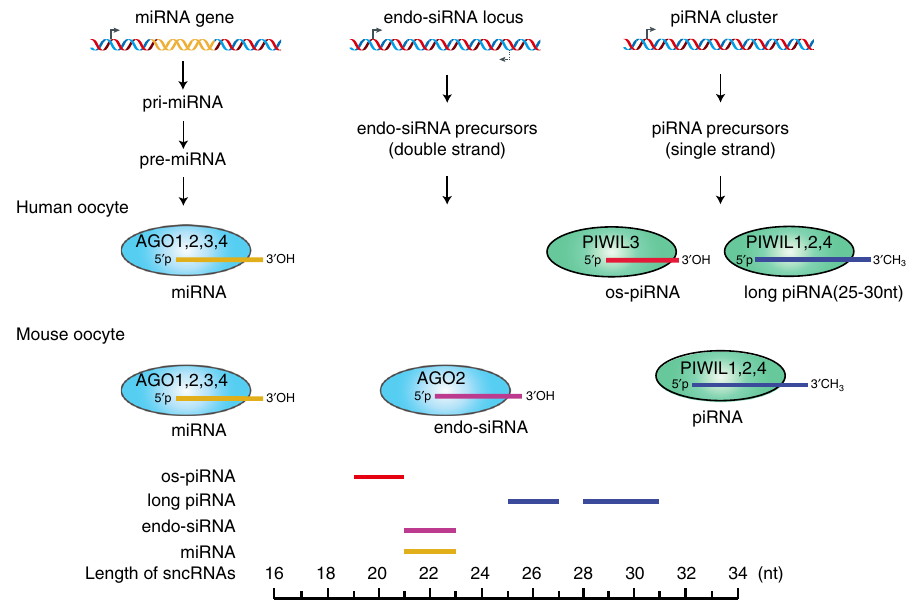
Fig. 7 Comparison of the Argonaute family proteins associated with small RNAs in human and mouse oocytes. MicroRNA (miRNA), endo-small interfering RNA (endo-siRNA), and PIWI-interacting RNAs (piRNA) are the three types of small RNAs that bind to Argonaute family proteins. Uracil (U) is the preferred fi rst nucleotide for all the types of piRNAs, and adenine (A) is the preferred tenth nucleotide. Compared to the other piRNAs in oocytes, the HIWI3-associated 20-nt oocyte short piRNAs (os-piRNAs) are shorter and do not bear the 2 ′ -O-methylated modi fi cations at the 3 ′ terminus. The expression of long piRNAs ( ≥ 25 nt) was relatively lower than the expression of os-piRNAs (~20 nt) in human oocytes and the expression of endo-siRNAs (~22 nt) in mouse the simultaneous degradation of endo-siRNAs and piRNAs in early embryos of mice 28,32 , these 20-nt os-piRNAs declined more rapidly than the 30-nt piRNAs in human morula embryos (Fig. 6a) and correlated with the disappearance of HIWI3 mRNA during human embryo development (Supplementary Fig. 4a) 40 .